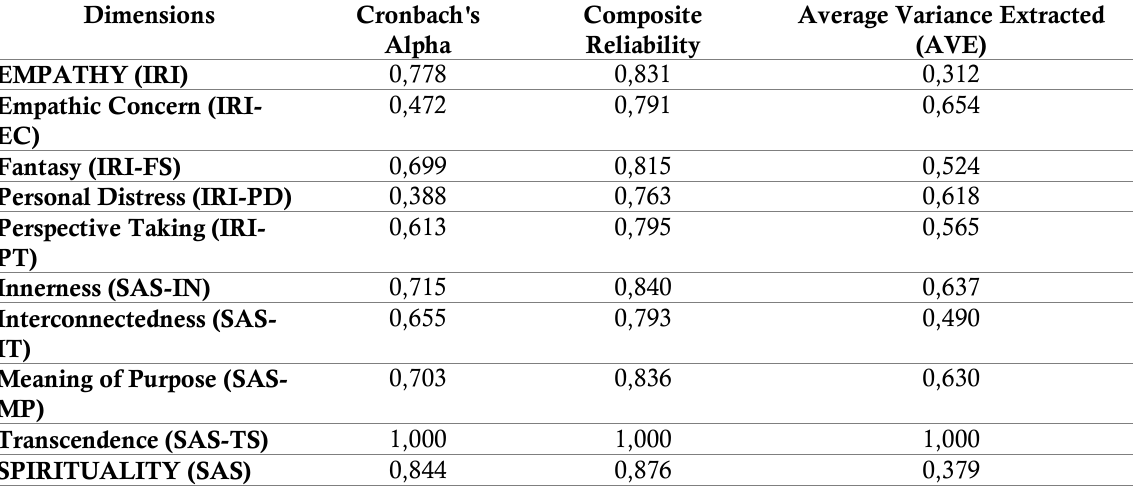
Table 1. Validity and Reliability